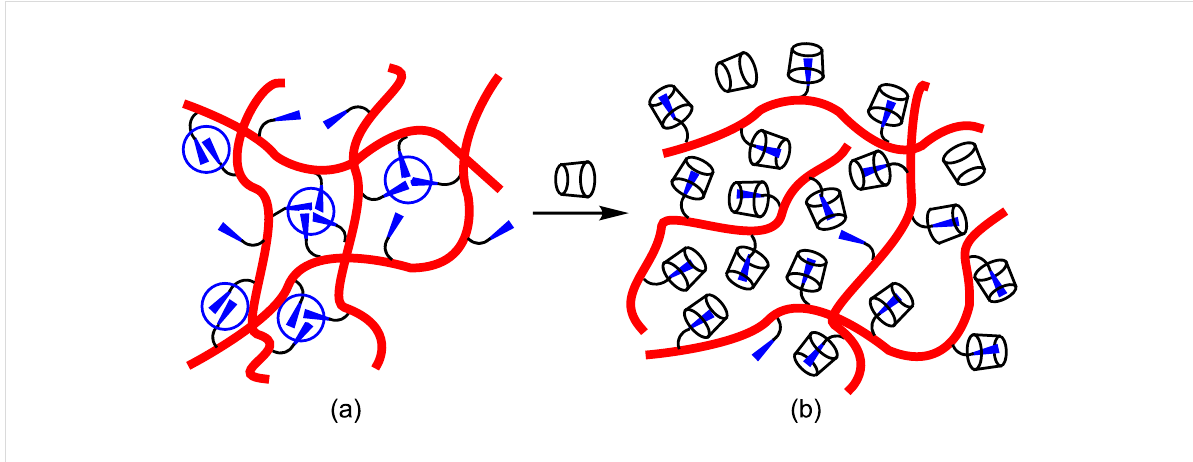
Figure 2: Associations of hydrophobic substituents (circled) (a) and their disruption through host–guest complexation by cyclodextrins (b).